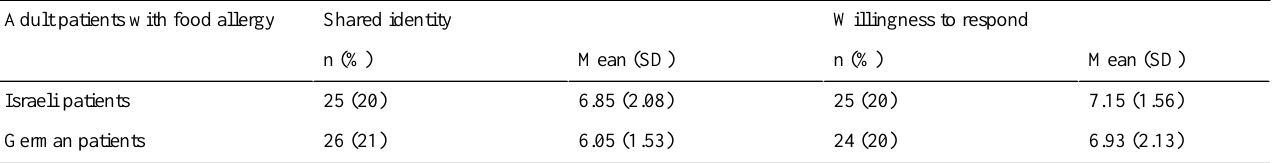
Table 3. Scores for shared identity and willingness to respond among Israeli and German adult patients with food allergy.